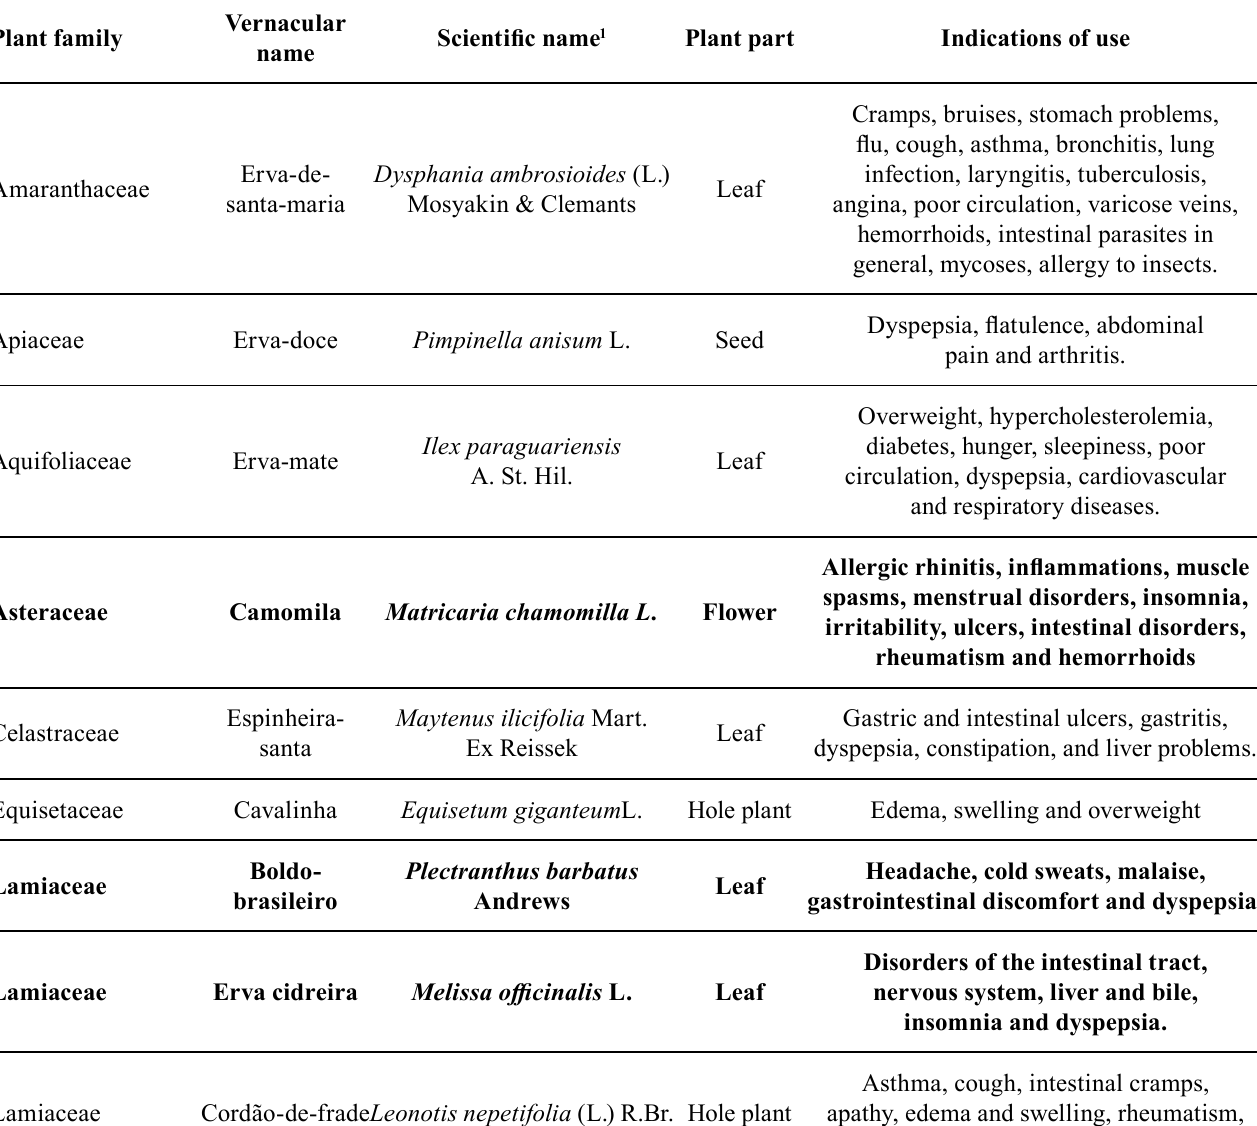
TABLE III – Correlation of the ethnospecies mentioned by the respondents (vernacular name) with the corresponding families, species, plant part and indications of use cataloged in The Plant List (2013). Bold letters indicate the most cited plant species